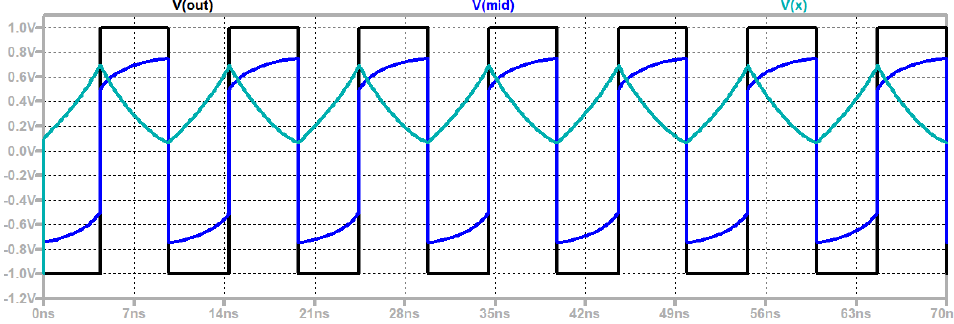
Figure 12. A memristor-based reactance-less generator.